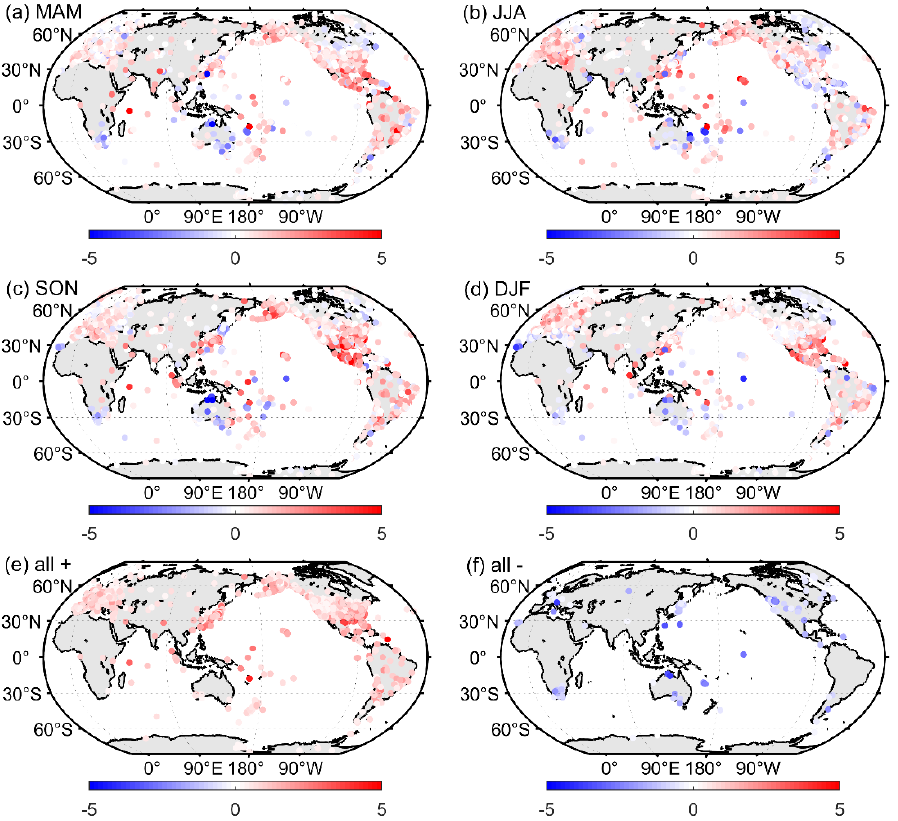
Figure 9. Spatial pattern of seasonal PWV trends during 1994–2020. ( a ) March–April–May (MAM), ( b ) June–July–August (JJA), ( c ) September–October–November (SON), ( d ) December–January–February (DJF), ( e ) stations with positive values in all four seasons, ( f ) stations with negative values in all four seasons.